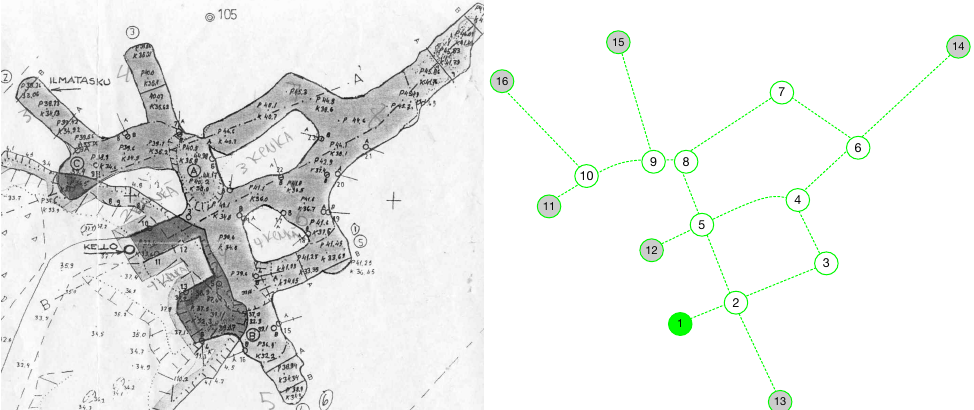
Figure 3. ( Left ): handwritten map of Kaatiala mine. ( Right ): topology graph of the mine. Gray note correspond to dead ends, and the green node is the mine entrance